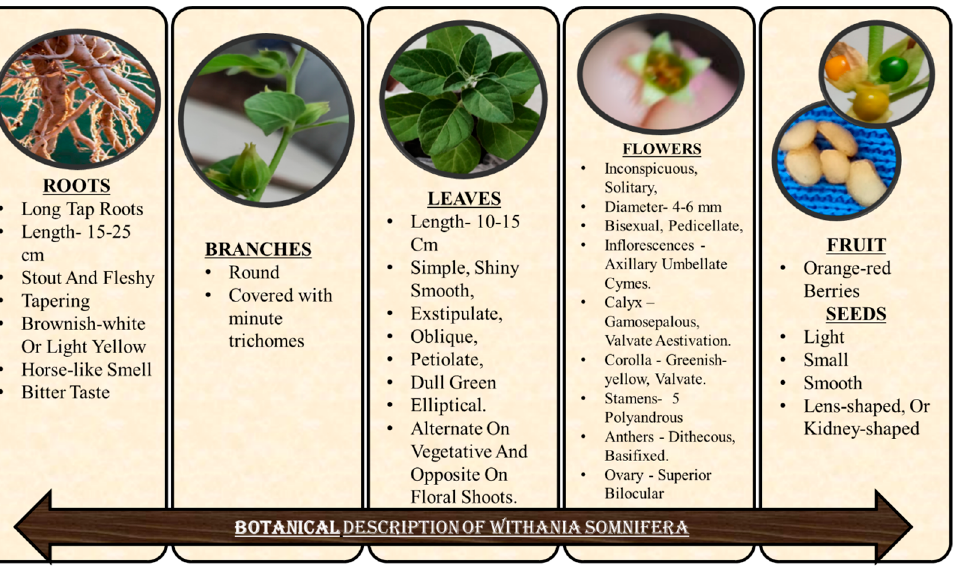
Figure 1. Botanical description of W. somnifera .